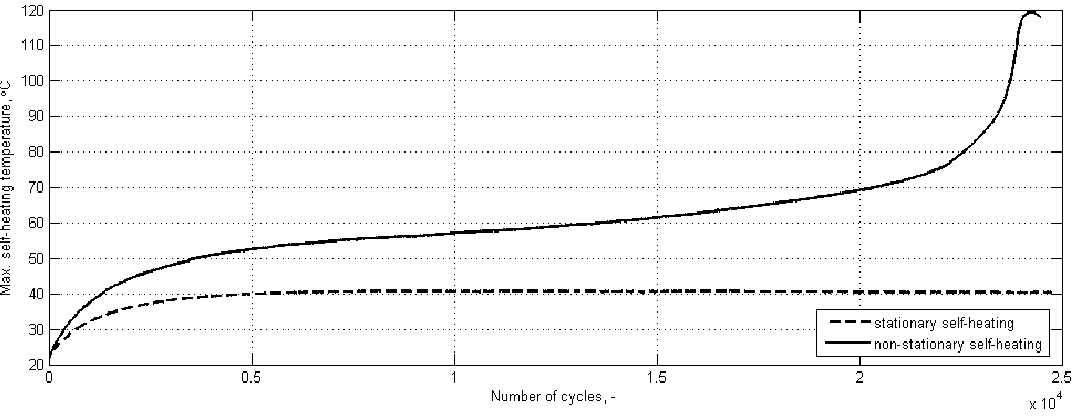
Figure 4. Physically possible scenarios of self-heating.